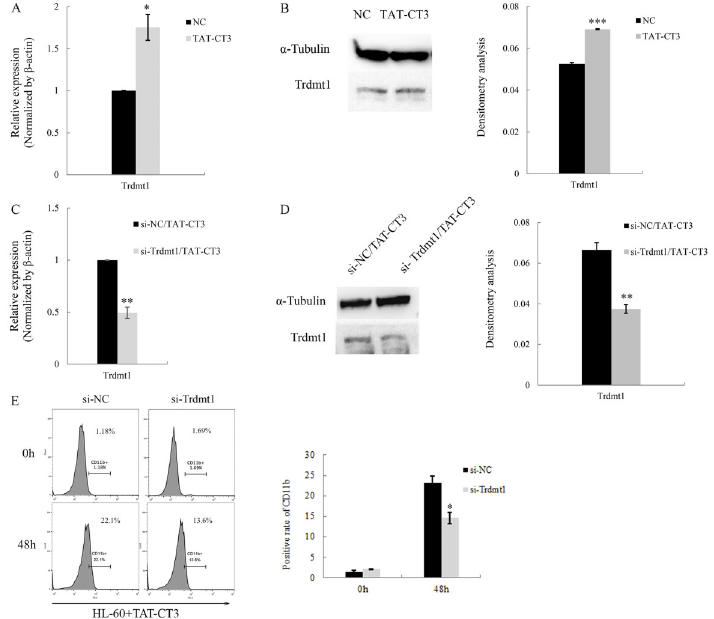
Figure 1. A , qPCR analysis of Trdmt1 mRNA in HL-60 cells following 2 days of TAT-CT3 treatment at a concentration of 50 m g/mL. B , Western blot analysis and corresponding densitometry analysis of Trdmt1 protein in HL-60 cells treated as described in panel A. C, qPCR analysis of Trdmt1 mRNA in HL-60 cells transfected with Trdmt1 siRNAs (si-Trdmt1) and control (si-NC) following 2 days of TAT- CT3 treatment at a concentration of 50 m g/mL. D, Western blot analysis and corresponding densitometry analysis of Trdmt1 protein in HL-60 cells transfected with Trdmt1 siRNAs (si-Trdmt1) and control (si-NC) following treatment as described in panel C. E , Flow cytometry analysis of the granulocytic differentiation marker CD11b in HL-60 cells transfected with si-Trdmt1 and control, and the percentage of CD11b-positive cells are indicated. Data are reported as means ± SD. *P o 0.05; **P o 0.01; ***P o 0.001 (ANOVA or Student ’ s t -test).